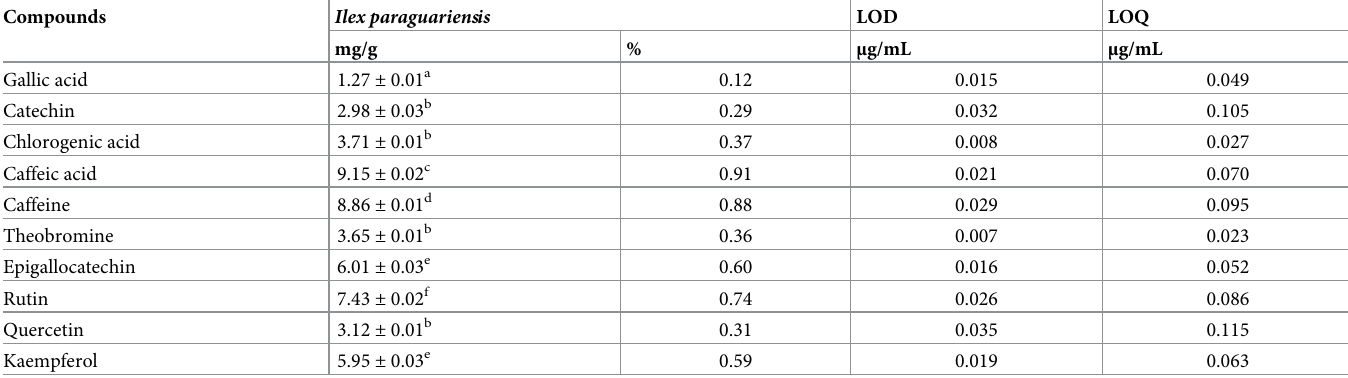
Table 1. Composition of Ilex paraguariensis aqueous